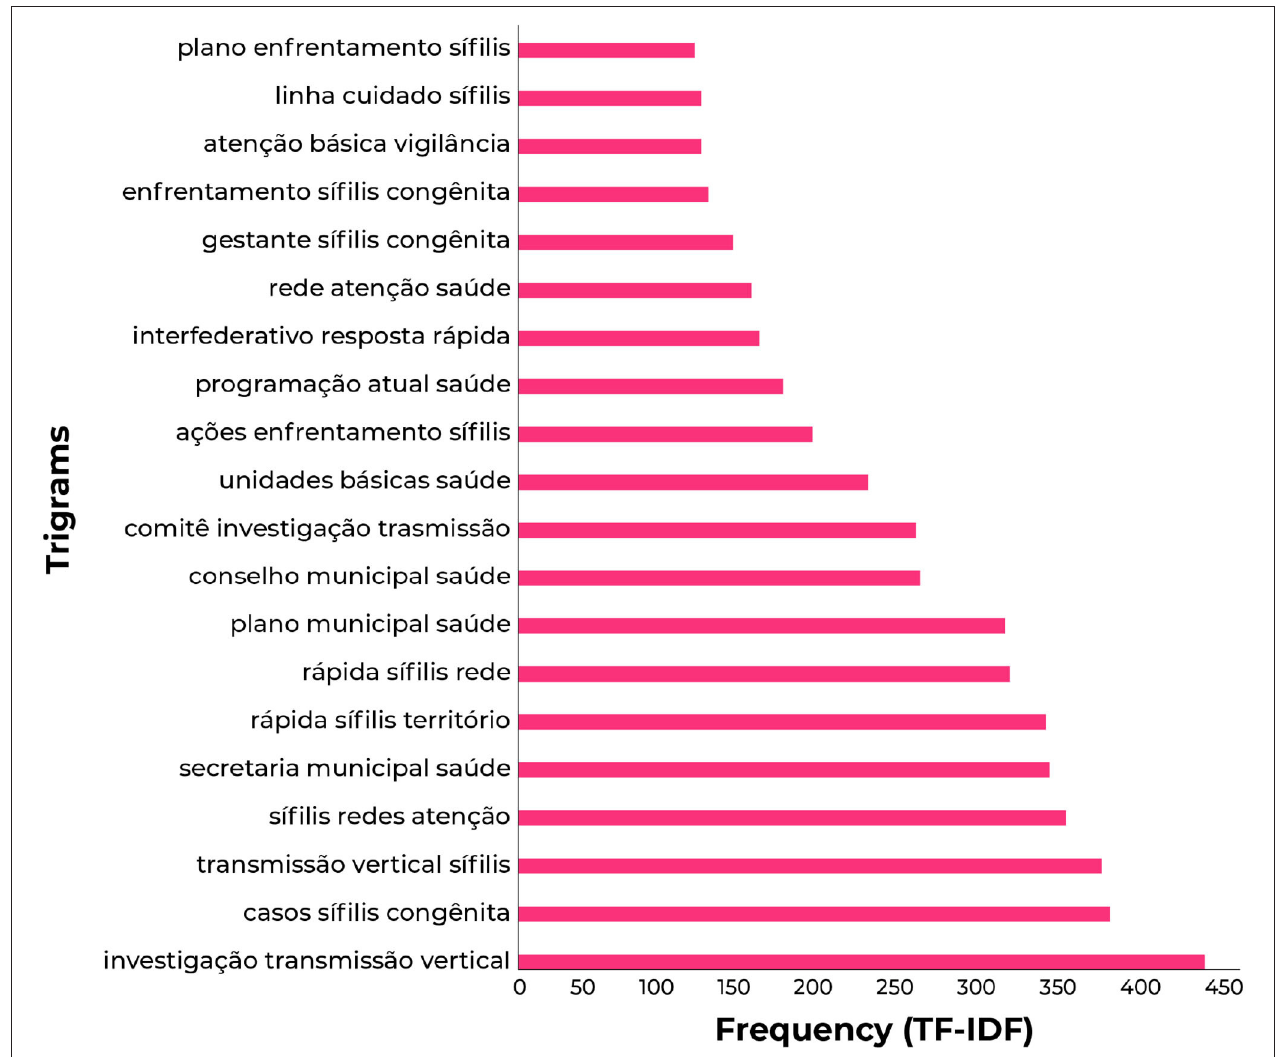
FIGURE 7 | The 20 most common trigrams in reports.